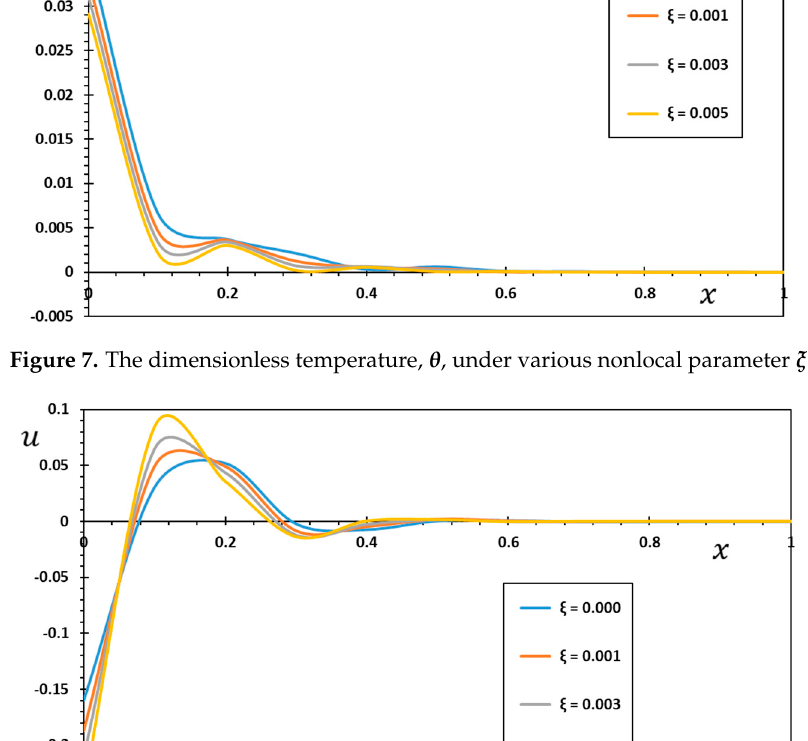
Figure 9. The bending moment, 𝑴 , under various nonlocal parameter 𝝃 values. Researchers can use the results of this study to learn more about the instability of nanobeam-based tiny devices and make adjustments to their designs to boost their overall performance. As an added extra, this study’s results provide a rationale for why nonclas- sical frameworks, small-scale influences, and external dynamic and thermal force im- provements to theoretical and experimental data provide different results when analyzing the reactions of the nano-system. Small-scale parameters are shown to be sensitive to the structure’s geometry, the qualities of the material it is made of, and the loads placed on it by means of the nonlocal interaction range factor. For this reason, ultra-small electronics based on nanostructures can only be modeled using nonlocal models.